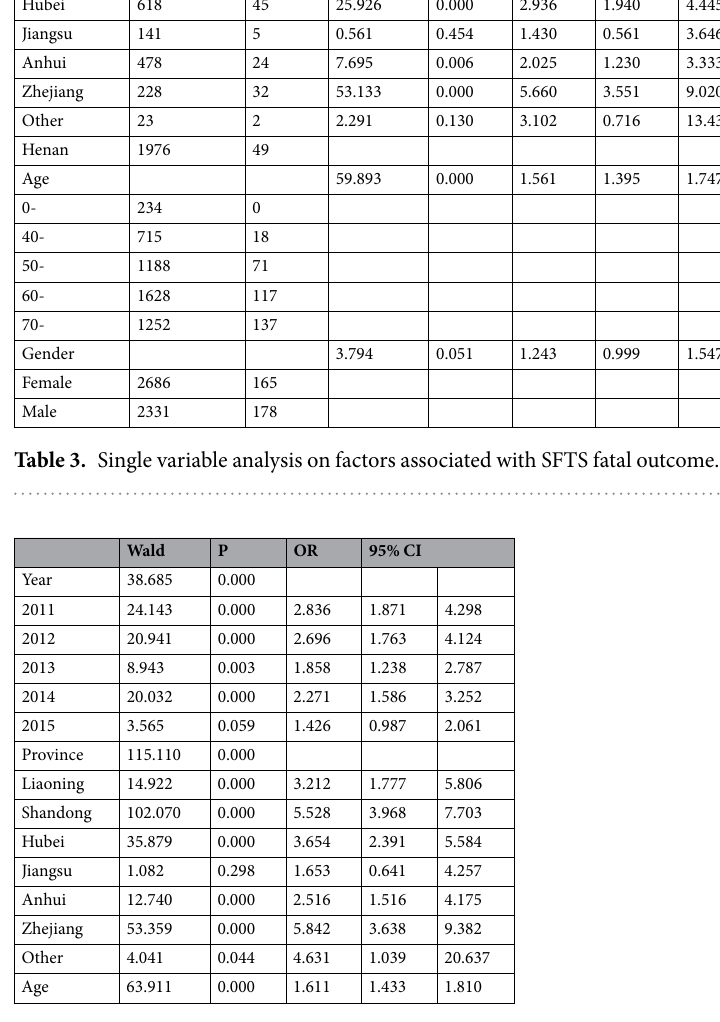
Table 4. Multivariable analysis on factors associated with SFTS fatal